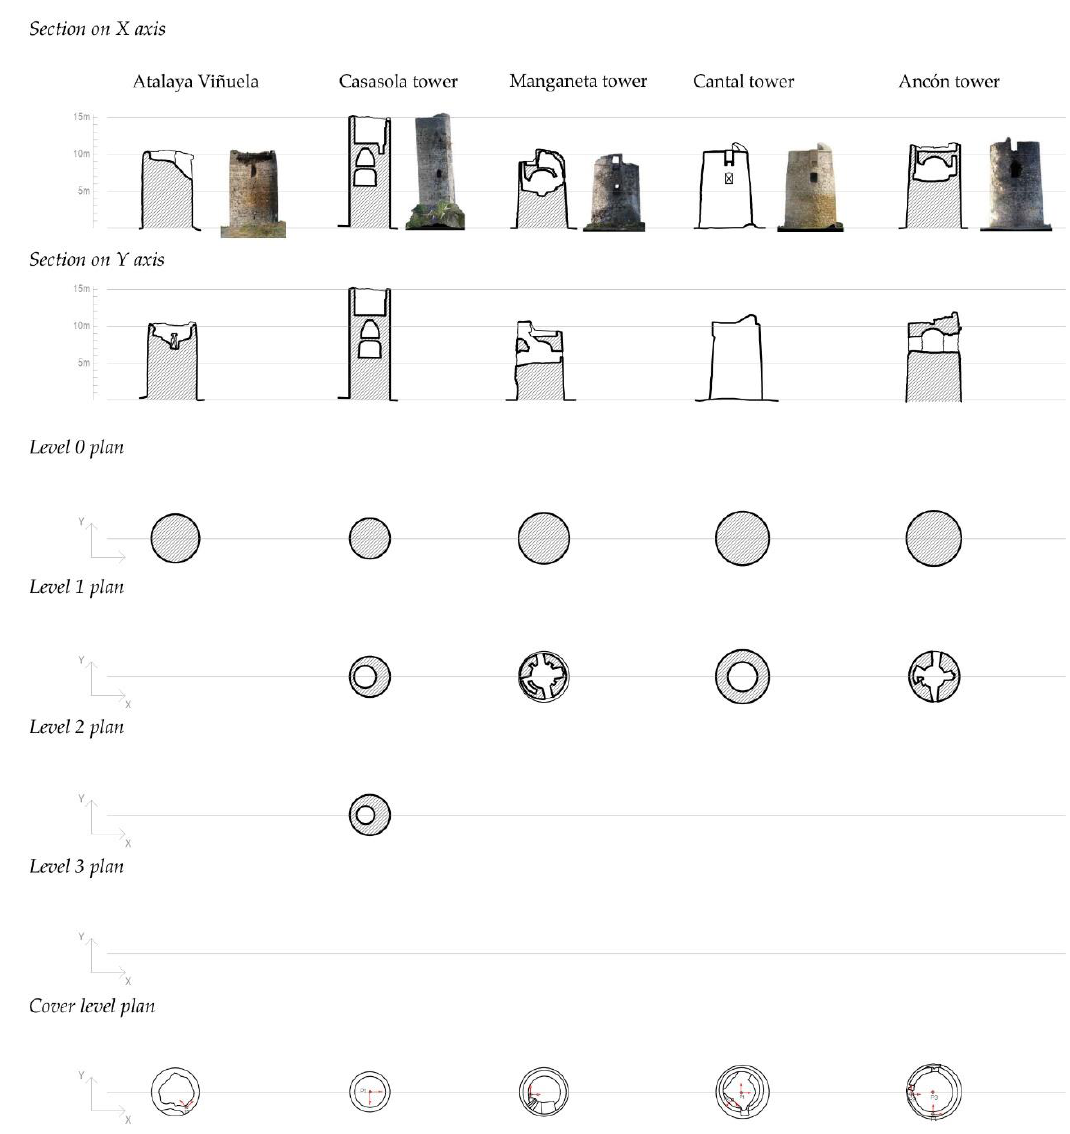
Figure 4. Description of elevations and plans of towers in this study .